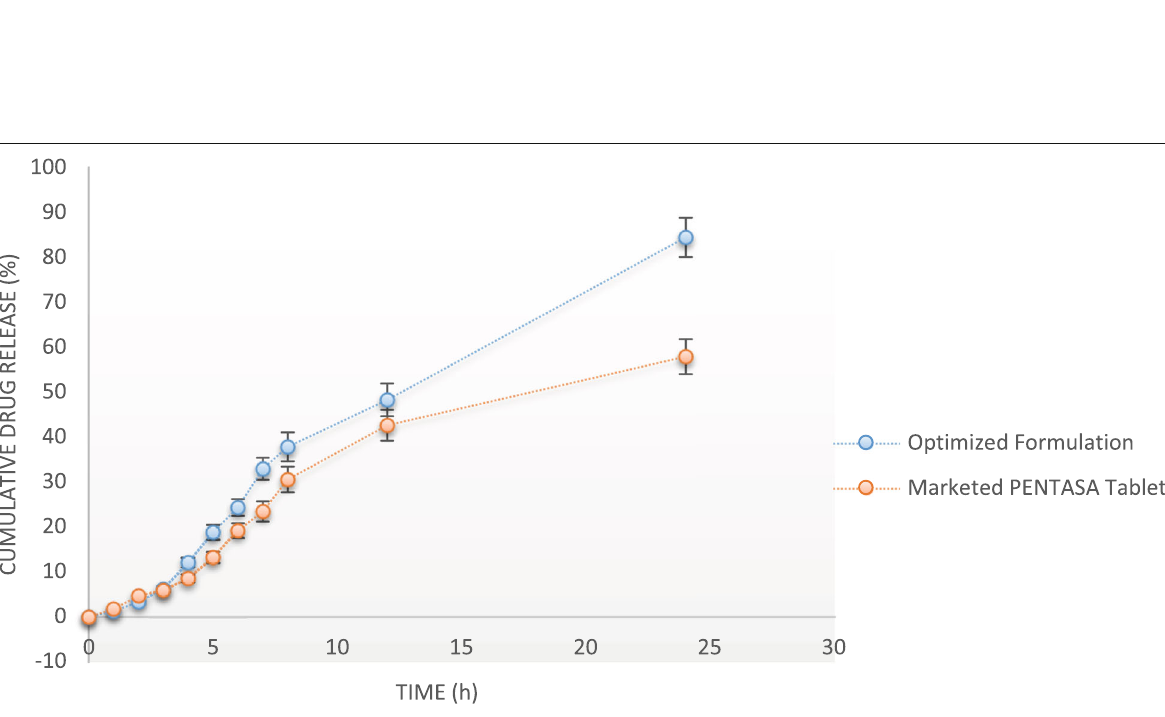
Fig. 9 Cumulative drug release (%) profile of the optimized